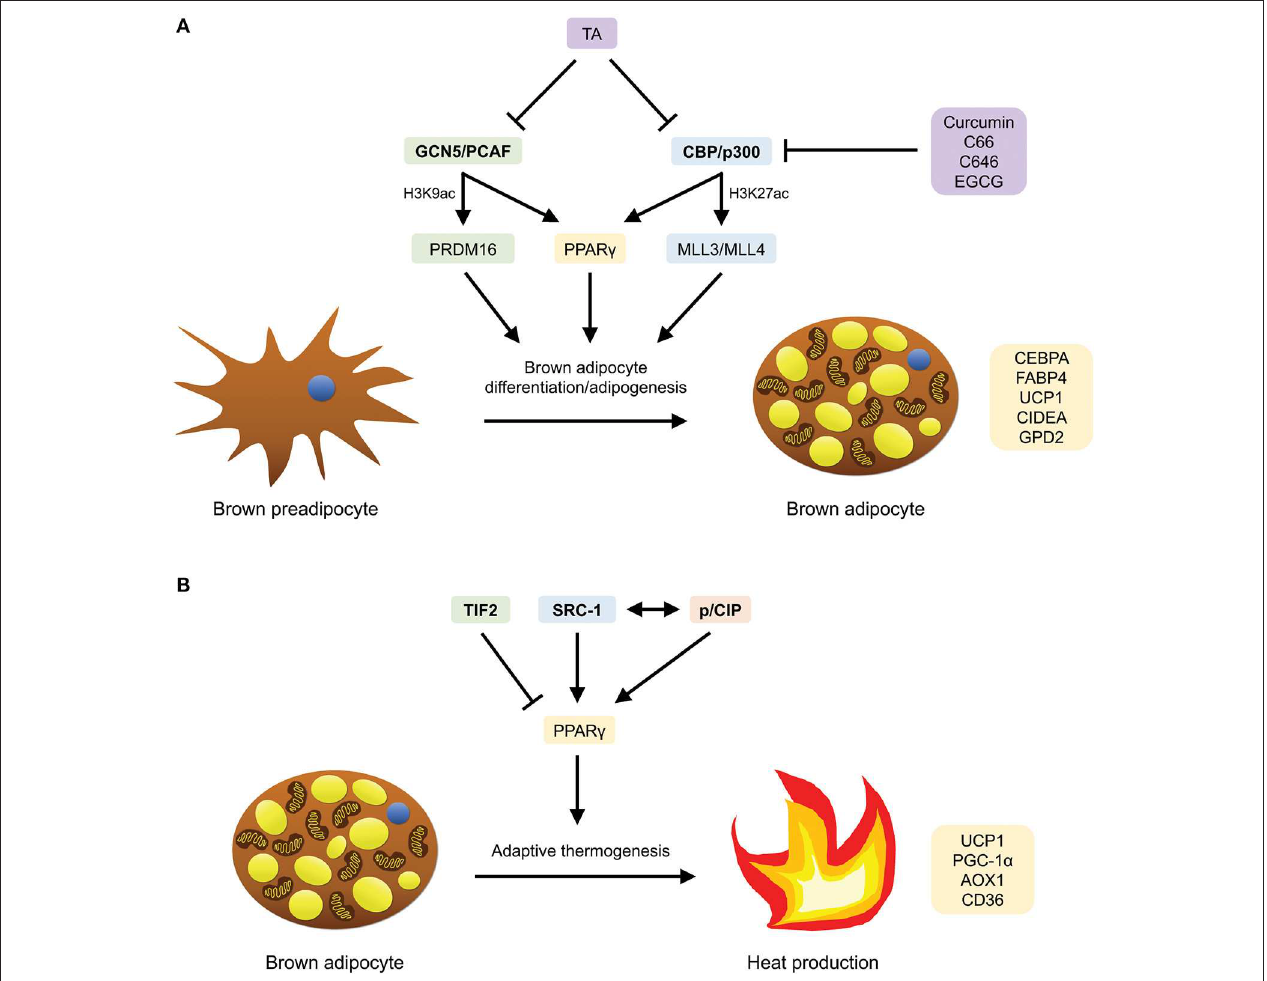
FIGURE 3 | HATs that are involved in brown adipocyte differentiation/adipogenesis and adaptive thermogenesis, as well as compounds (HATis) that have been demonstrated to inhibit them. (A) GCN5/PCAF and CBP/p300 mediate brown adipocyte differentiation/adipogenesis by inducing the expression of PPAR γ -target, BAT-selective, thermogenic and adipogenic genes through PRDM16 and MLL3/MLL4, respectively, as well as PPAR γ . (B) TIF2, SRC-1 and p/CIP mediate adaptive thermogenesis by inducing the expression of BAT-specific PPAR γ -target genes. SRC-1 and p/CIP have also been shown to interact with each other to regulate the expression of these